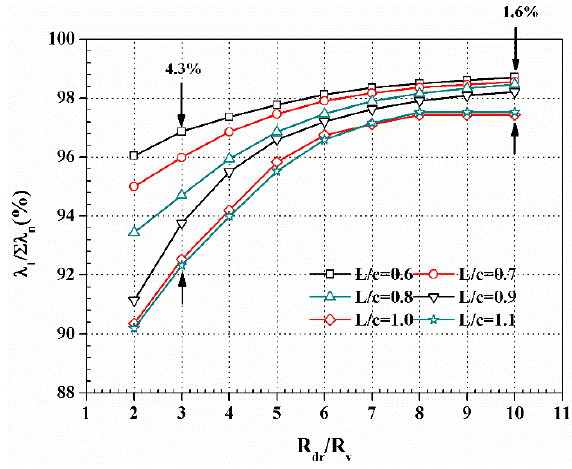
Figure 13. Mode 1 energy fraction at different decomposition region sizes and different chord position.